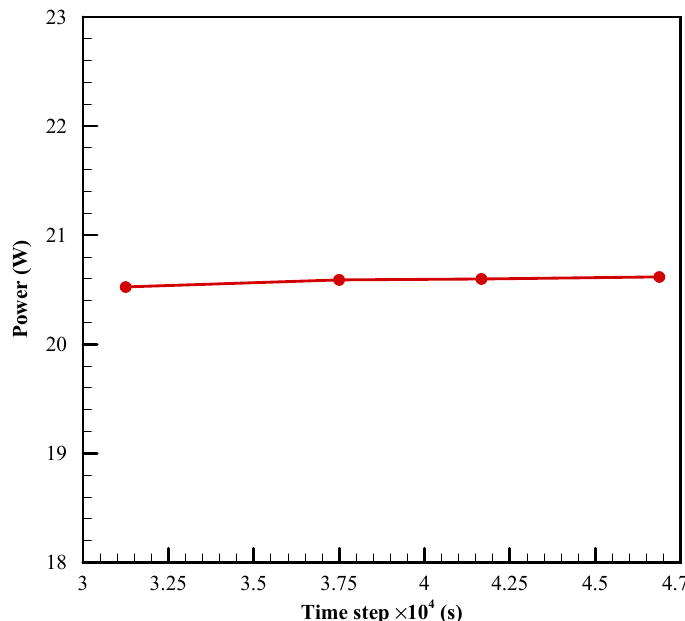
Figure 3. Time step independence check.